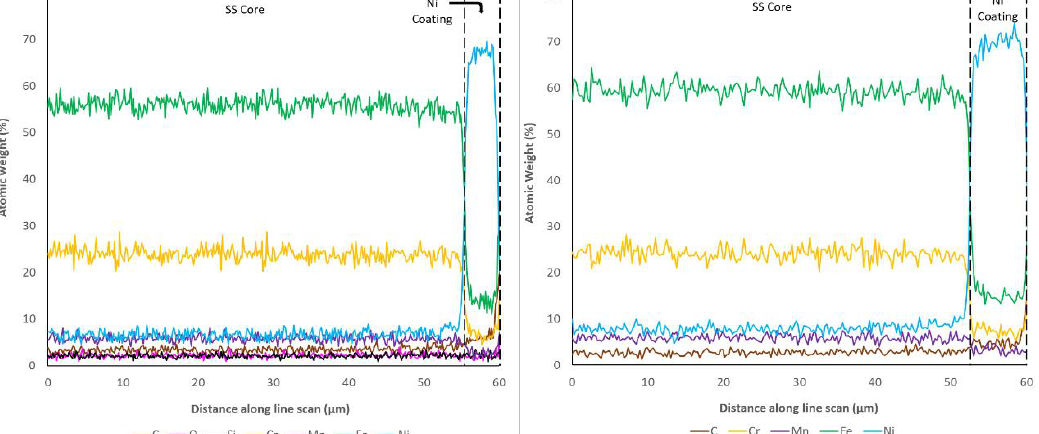
Figure 19. Element atomic weight distribution for the SS Ni + Cu thin-walled pipe ( left , 8) and thick-walled pipe ( right , 9) at the core-coating boundary.